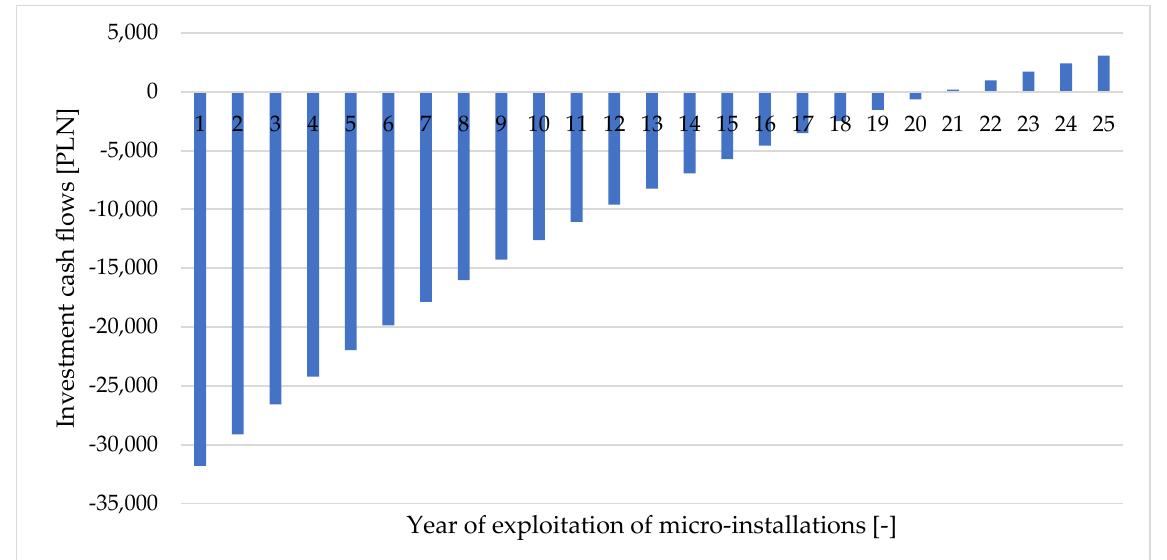
Figure 12. Graph showing the cash flow of the investment as a function of time of its operation for the net-billing system based on hourly prices and 50% self-consumption level with energy storage.